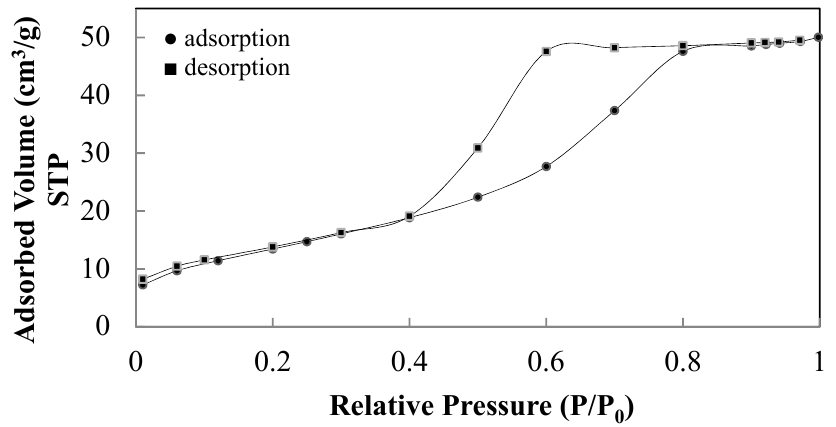
Figure 14. Pore size distribution of sample hydrolysed at r.t. for 1 h with 1.0 M NH 4 OH, peptized for 1 h with 0.02 M HNO 3 , dried by lyophilization and calcined for 2 h at 450 °C with a ramp rate of 30 °C/min.